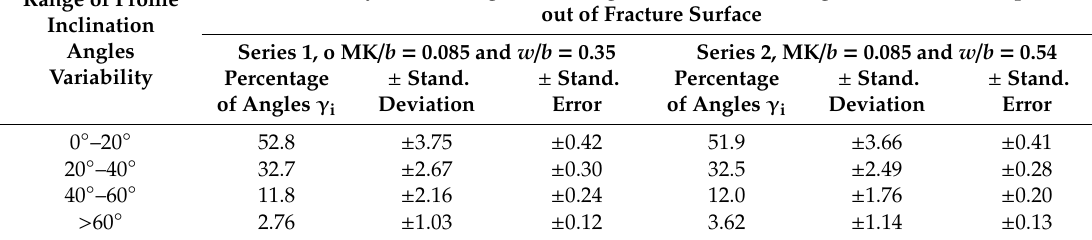
Table 3. Results of analysis of the histograms of angles γ i occurrence frequency, identifying fracture development direction. Results of Analysis of Histograms of Angles Distribution along the Profile Line